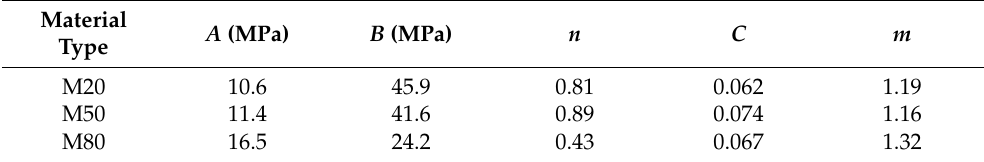
Table 5. Johnson–Cook constitutive parameters of the materials.